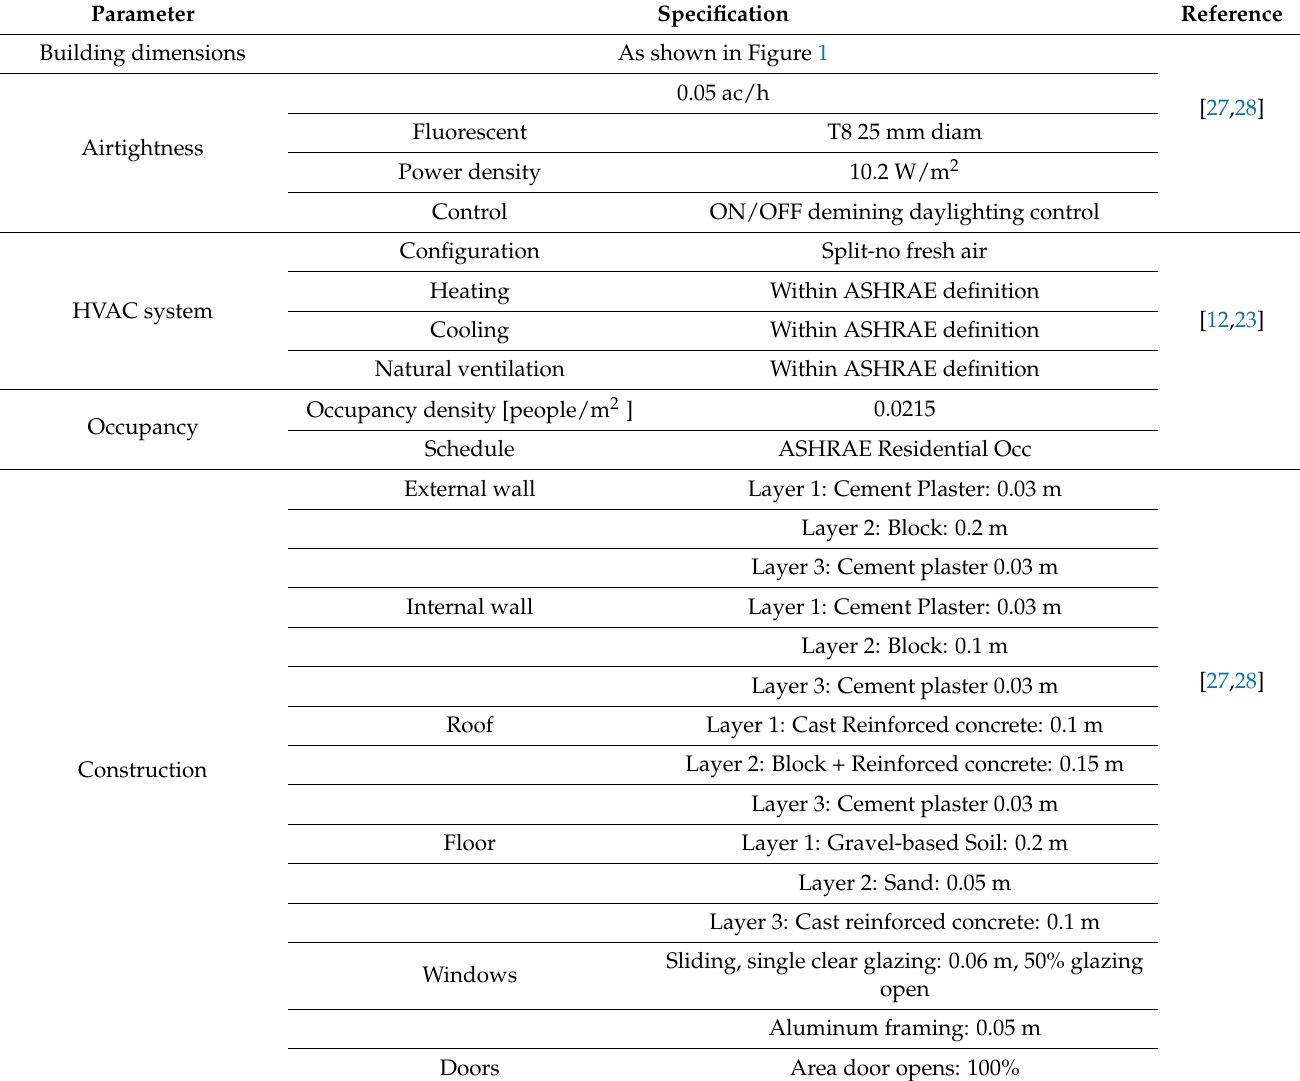
Table 2. Design specification and assumptions of the generic